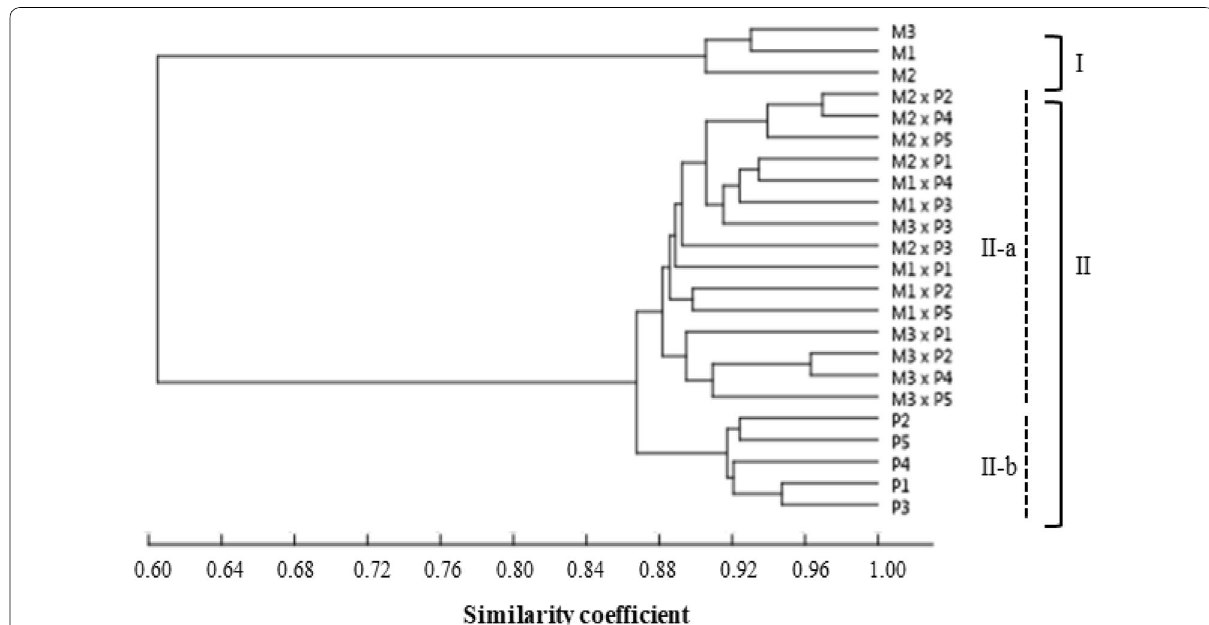
Fig. 4 Cluster analysis based on genetic similarity between B. rapa and B. napus varieties and F 1 hybrids. UPGMA cluster analysis was constructed using the PAST program. M1: “Nongxing 80 days,” M2: “Wansheng rape,” M3: “Edible rape,” P1: “Deza oil No. 18,” P2: “Gueiza No. 4,” P3: “Zhong oil No. 36,” P4: “Wan oil No. 25,” and P5: “FTHEB 1001”